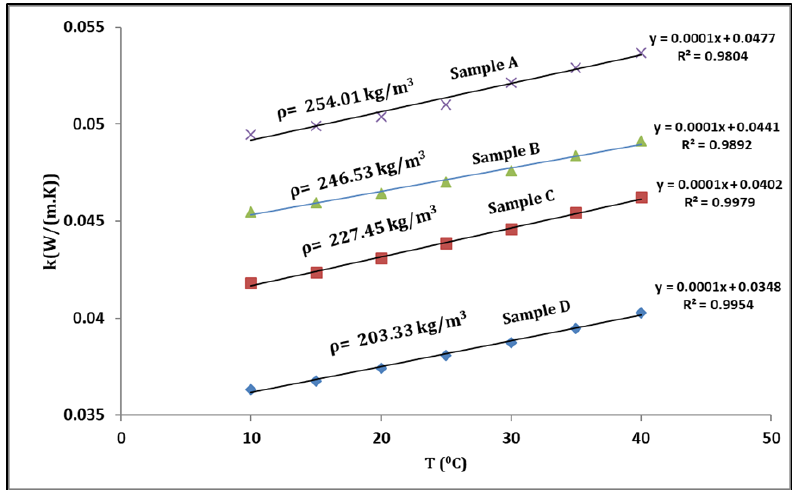
Figure 8. Linear regressions of thermal conductivity as a function of temperature.